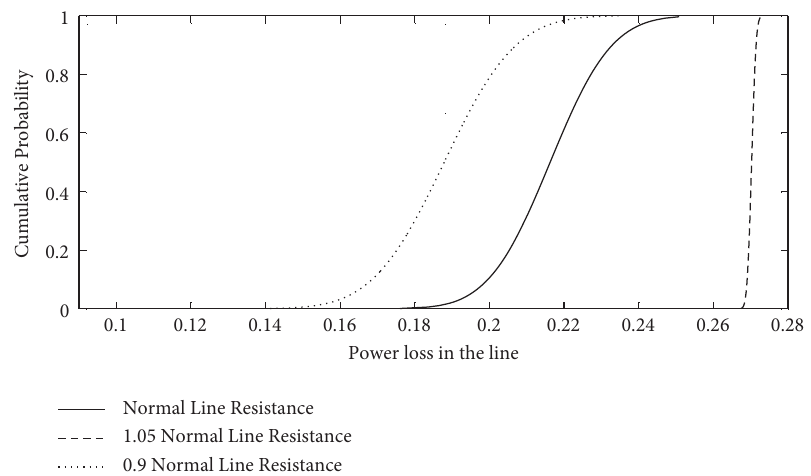
Figure 9: Distribution function of power loss in the line connecting the bus nos. 4 and